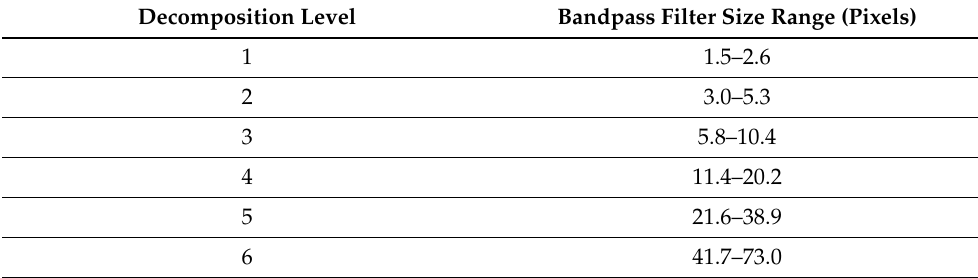
Table 1. Full width at half maximum ranges of the bandpass filters in the spatial domain. The pixel sizes of the acquisitions ranged between 0.07 and 0.15